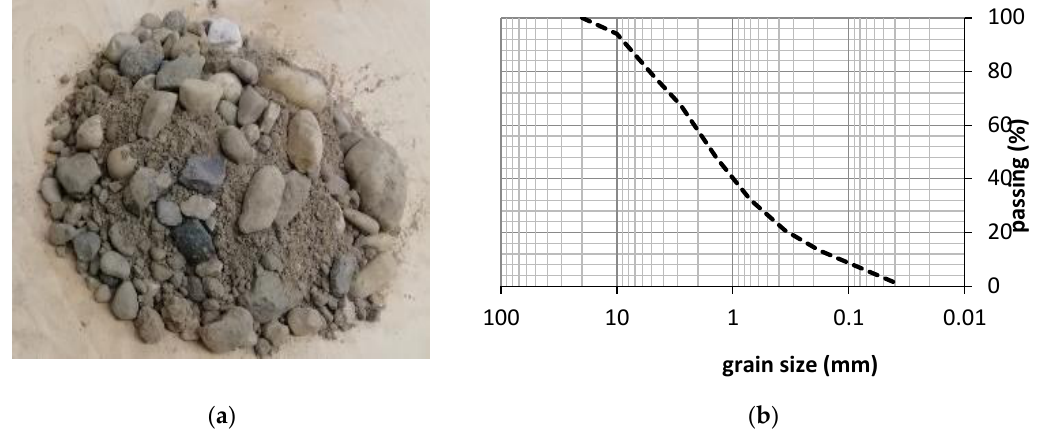
Figure 2. Picture of the tested soil ( a ) and grain size distribution ( b ).